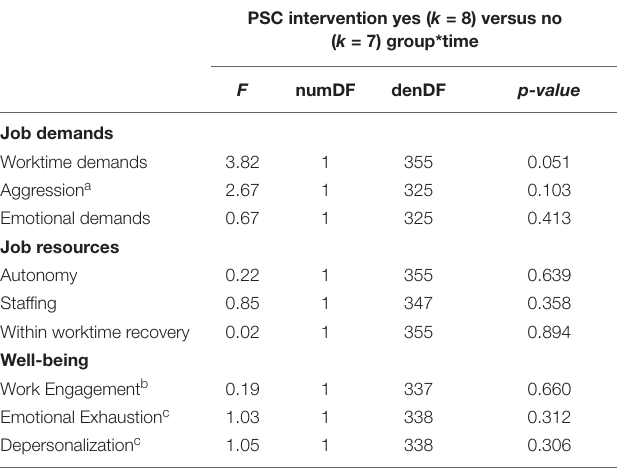
TABLE 4 | The moderating effect of implementing a psychosocial safety climate intervention on changes in job demands, job resources and employee well-being between T2 and